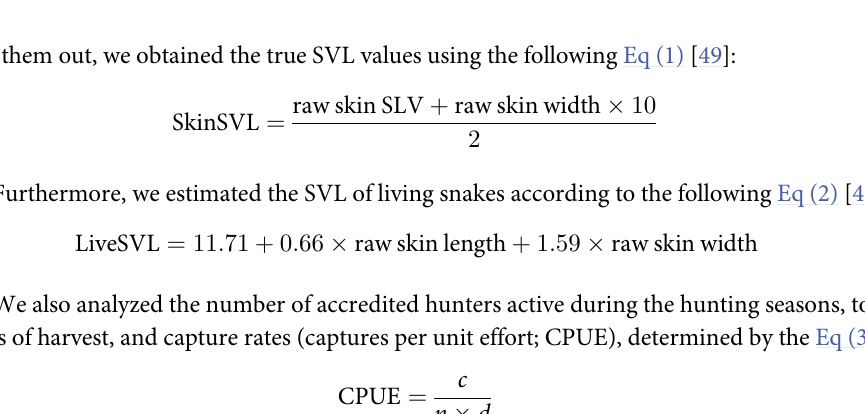
Fig 2. Yellow anaconda ( Eunectes notaeus ) basking in the sun on the champa at La Estrella marsh, northeastern Argentina. Photo by Programa Curiyu´.